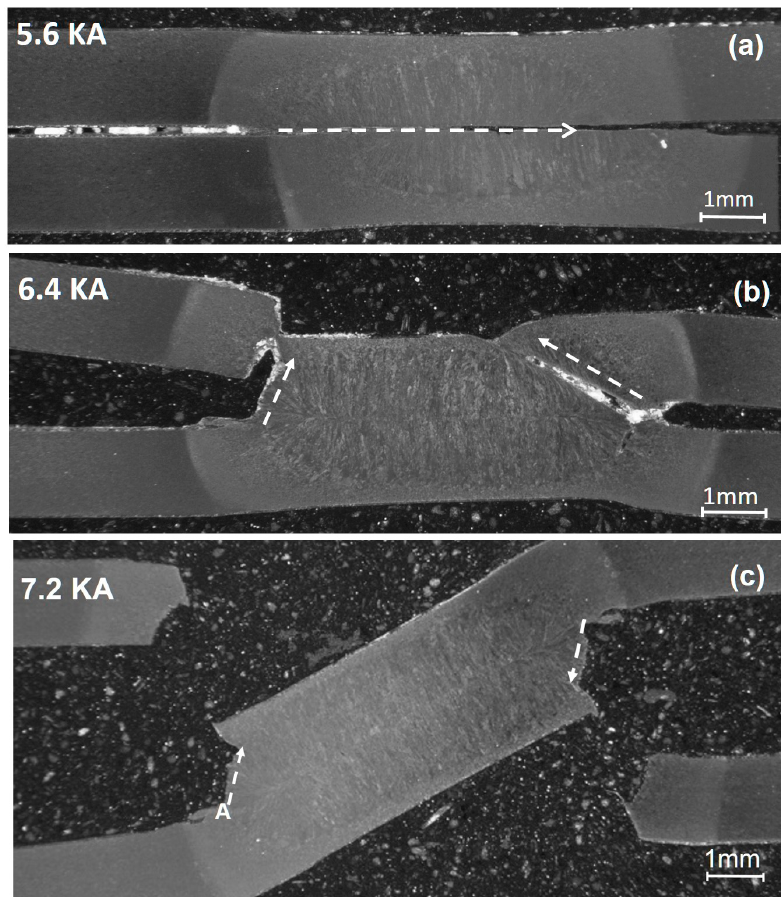
Figure 7. Fracture position and route of three modes: ( a ) IF; ( b ) PF I; ( c ) PF II.